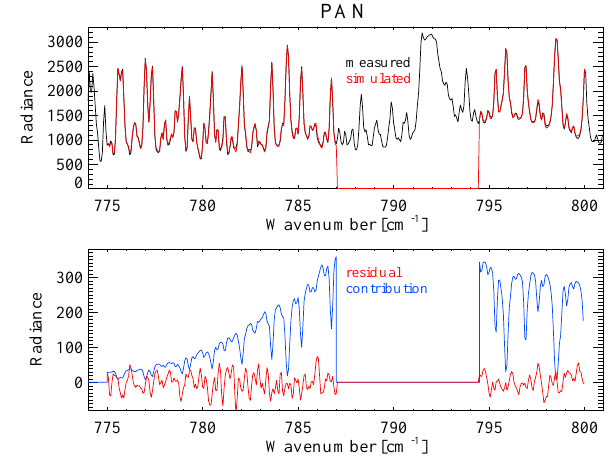
Fig. 8. As Fig. 2 but for PAN. The RMS difference for the shown set of microwindows is 26.9nW/(cm 2 srcm − 1